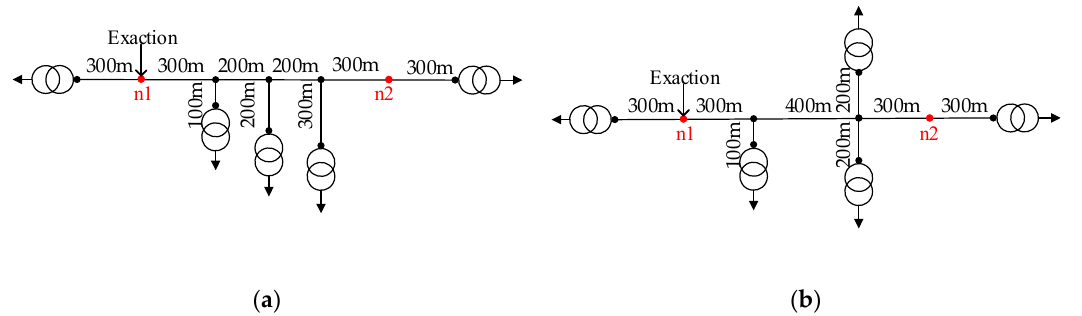
Figure 6. Examples of the medium-voltage radial distribution networks with three branches: ( a ) The distribution network with three branch points and ( b ) the distribution network with two branch points.